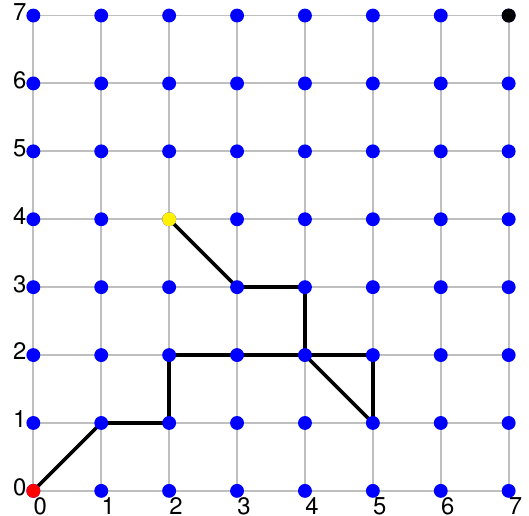
Sample basic-cameras network (Red node—entry, black node—exit, yellow node— current position, visited nodes are connected by